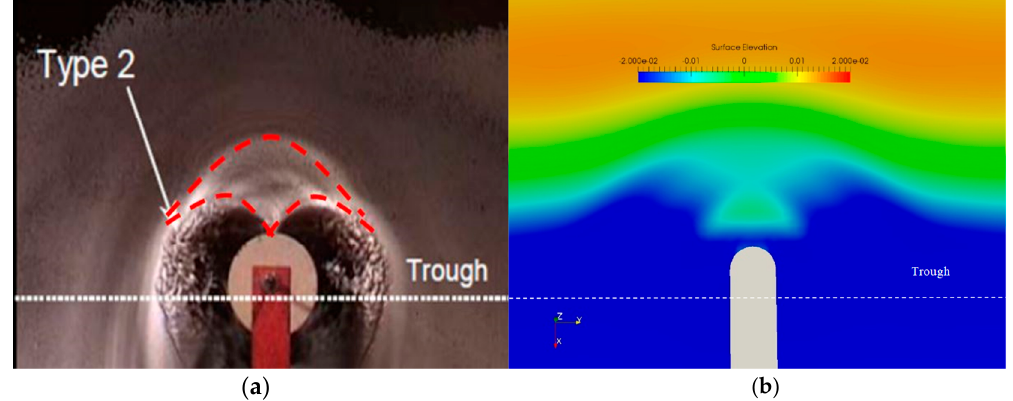
Figure 9. Free surface elevation around FPSO model: ( a ) wave tank test at t = 50.7 s; ( b ) present CFD at t = 51 s.